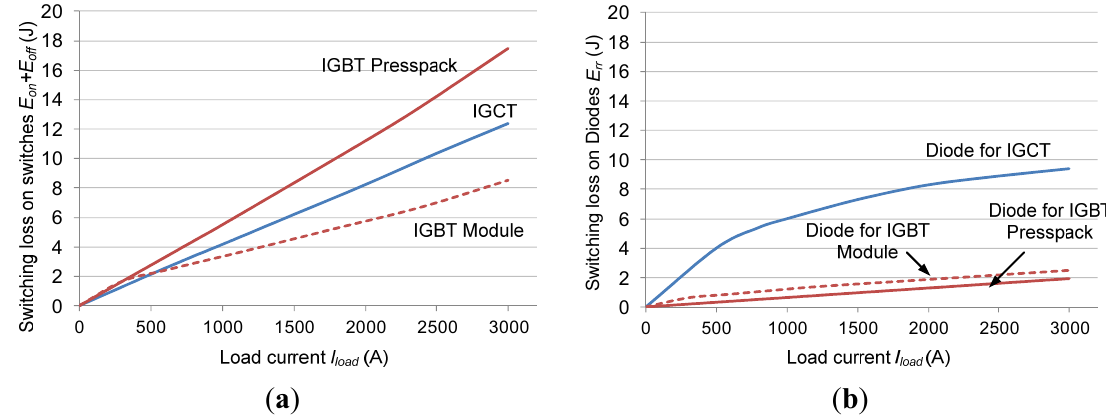
Figure 3. Normalized switching loss profiles for different power devices (recommended test conditions, 125 °C). ( a ) Switching loss on IGCT/IGBT E diode E . rr